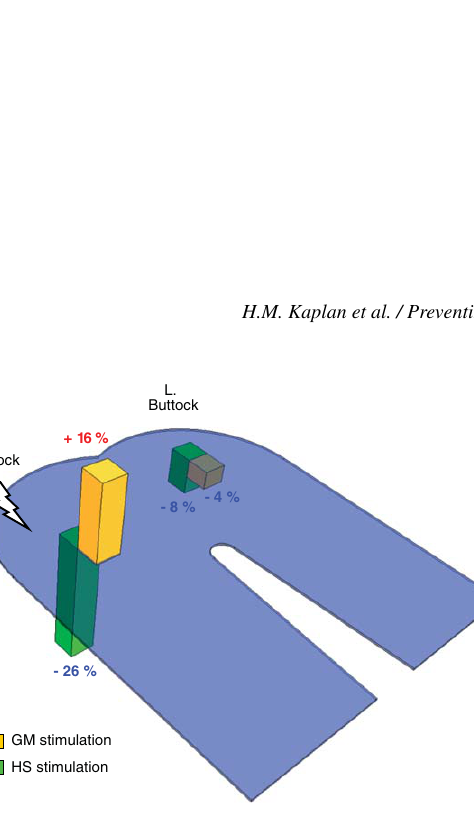
tle concern in themselves because these areas have no boney prominences and are not at risk for PUs (they are also the normal areas to which mobile individuals unload when shifting